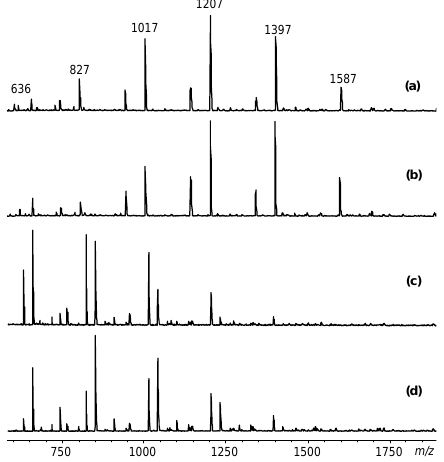
Figure 4. MALDI-TOF mass spectra of epoxycyclophosphazenes synthesized according to scheme A at molar ratios of HCP:phenol:bisphenol A = 1:2:5 ( a ), 1:2:6 ( b ), 1:4:3 ( c ), and 1:4:4 ( d ).